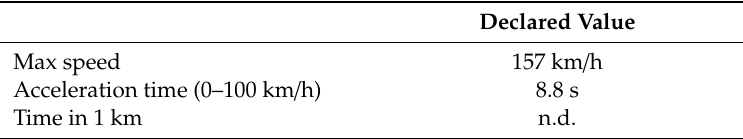
Table 27. Chevrolet Volt performance